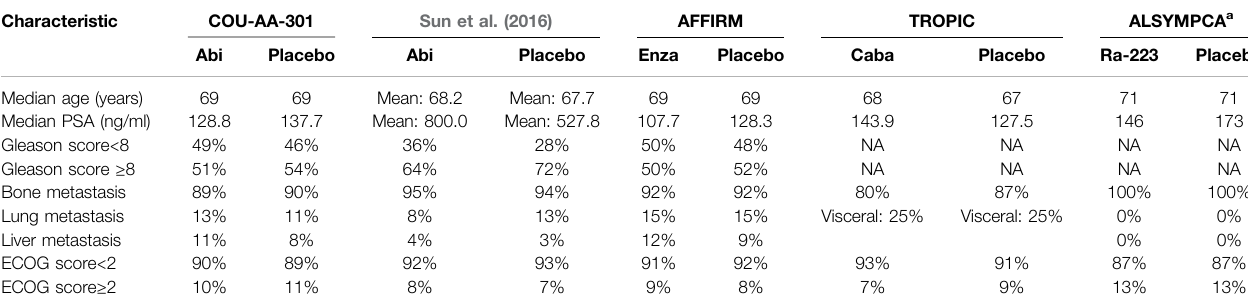
TABLE 2 | Baseline characteristics of included patients.